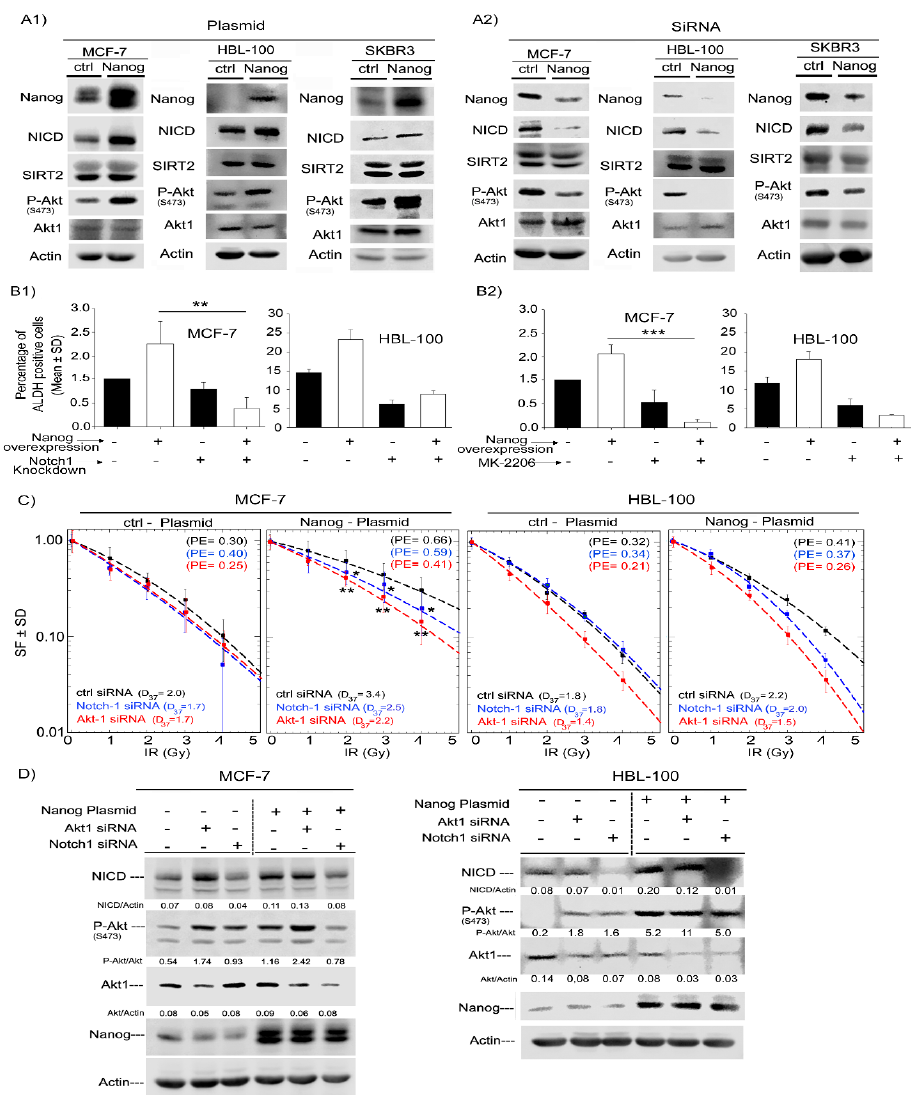
Figure 4. Nanog promotes ALDH activity and radioresistance through Akt and Notch1 proteins. ( A1 ) siRNA knockdown of Nanog or ( A2 ) Nanog overexpression was performed as described in the Materials and Methods Section in MCF-7, HBL-100 and SKBR3 cells. The transfection efficiency was tested after 48 h by Western blotting. ( B ) ALDH activity as a function of Nanog expression under Notch downregulation and Akt inhibition. Twenty-four hours after Nanog overexpression, cells were transfected with Notch1 siRNA. Forty-eight hours later, ALDH activity was measured with an Aldefluor assay ( B1 ). Twenty-four hours after Nanog overexpression, cells were treated with the Akt inhibitor MK-2206 (250 nM for MCF-7 and 1µM for HBL-100), and ALDH activity was measured 24 h later ( B2 ). Bars represent relative ALDH activity ± the standard deviation (SD) of three independent experiments (n = 6; ** p < 0.01, and *** p < 0.001, Student’s t-test). ( C ) Survival curve of irradiated cells after Notch1 and Akt knockdown or Akt inhibition in Nanog-overexpressing MCF-7 and HBL-100 cells. Twenty-four hours after Nanog overexpression, cells were transfected with Notch1 siRNA and 24 h later plated for colony formation. Twenty-four hours after plating, cells were irradiated (0 to 4 Gy). Colonies were stained after 10–14 days. MCF-7 data points represent the mean surviving fraction ± the standard deviation of two independent experiments ( n = 12; * p < 0.05, and ** p < 0.01, Student’s t-test). HBL-100 data points represent the mean surviving fraction ± the standard deviation of one experiment ( n = 6) ( D ) Nanog, Akt1 and Notch1 protein expression was analyzed via Western blotting after transfection with plasmid or siRNA under inhibitor treatment